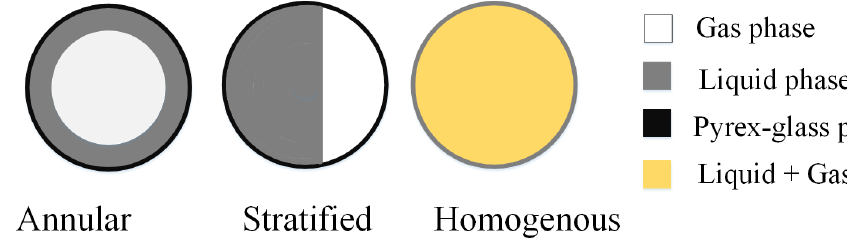
Figure 2. Simulated flow regimes.